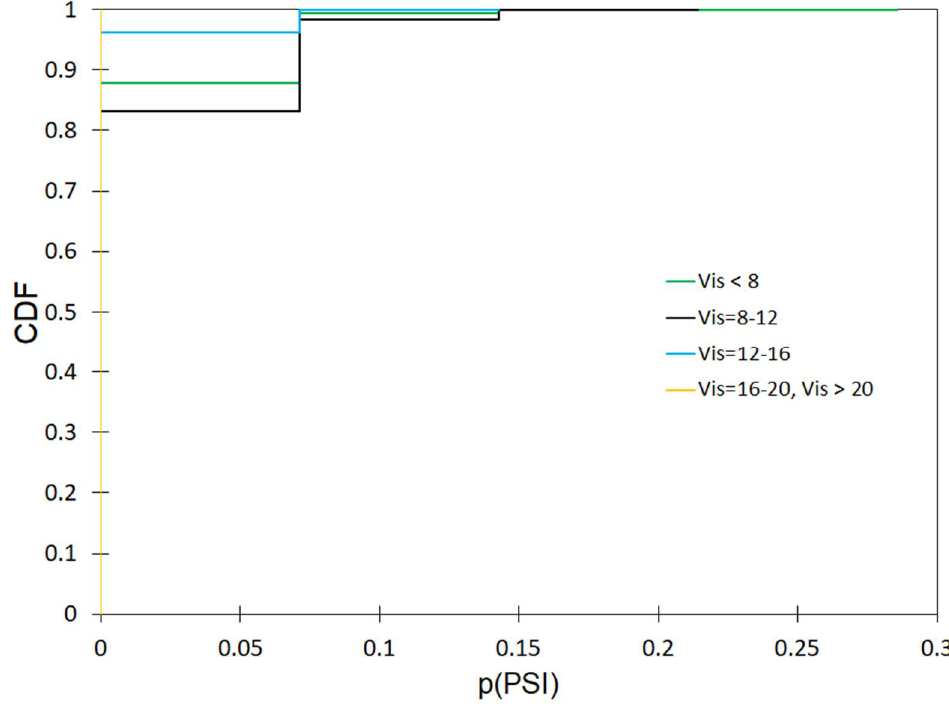
Figure A27. Effect of visibility on the incidence of very high winter mortality for dry days.